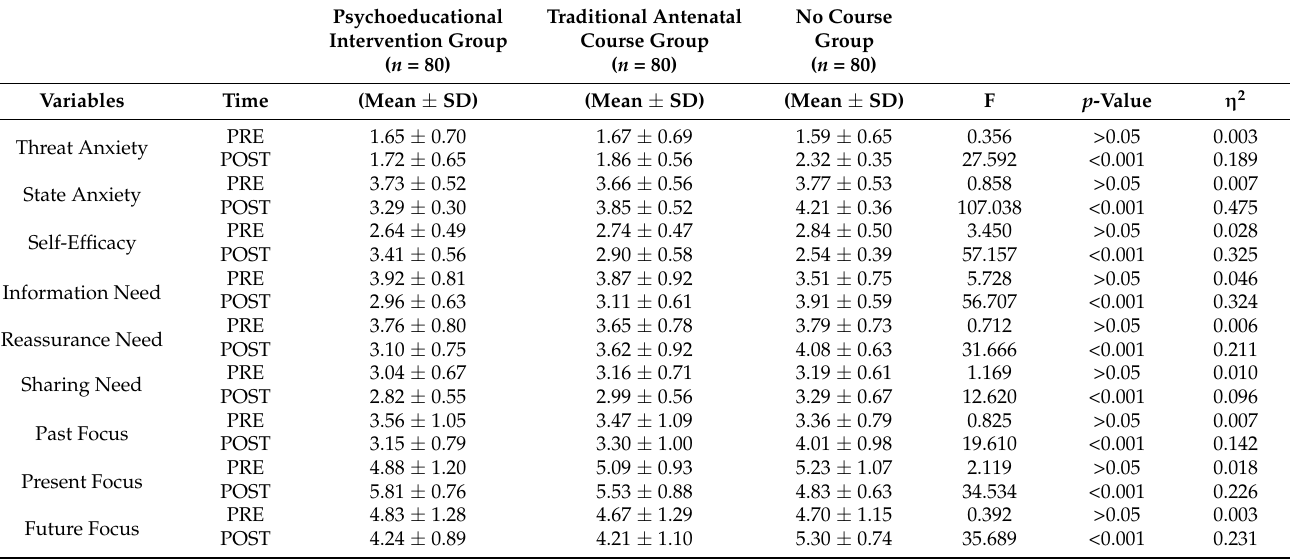
Table 2. Significant differences in the measurements between the three groups.